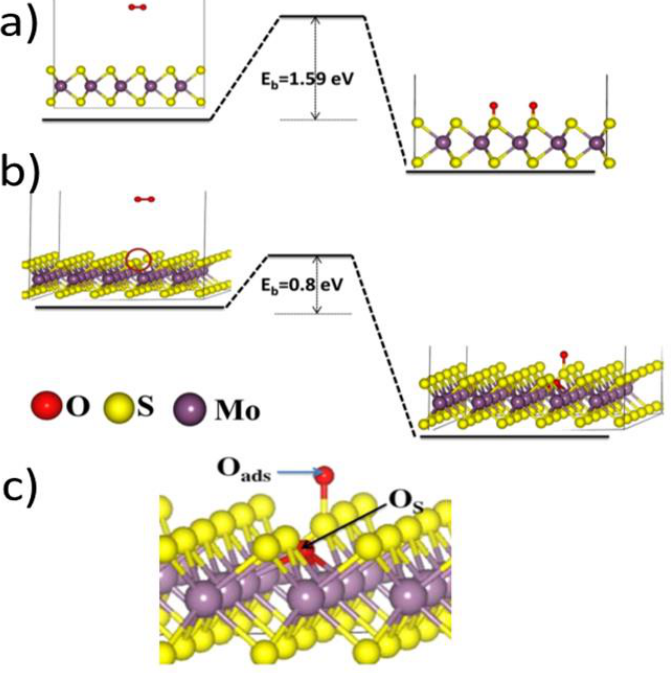
Figure 13. DFT calculations of oxygen dissociative adsorption on MoS 2 basal plane according to Santosh et al. [43]. ( a ) Pristine (non-defective) MoS 2 surface resulting in two adsorbed (O ads ) oxygen atoms on neighboring sulfur atoms; ( b ) S-deficient MoS 2 surface (SSV) resulting in one adsorbed O ads and one substitutional oxygen (O s ). ( c ) Close-up on the final state from ( b ) to show atomic po- sitions of O ads and O s . Reprinted from Reference [43], with the permission of AIP Publishing.